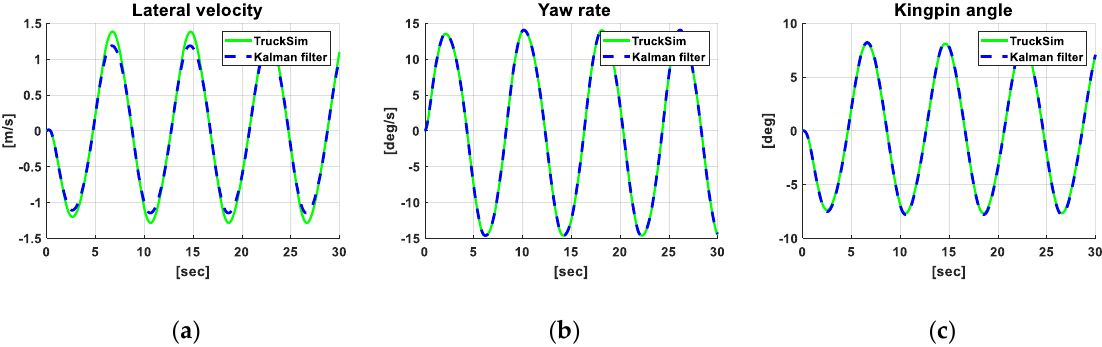
Figure 9. Comparison of simulation results of TruckSim and Kalman filter. ( a ) Lateral velocity; ( b ) Yaw rate; ( c ) Kingpin angle.